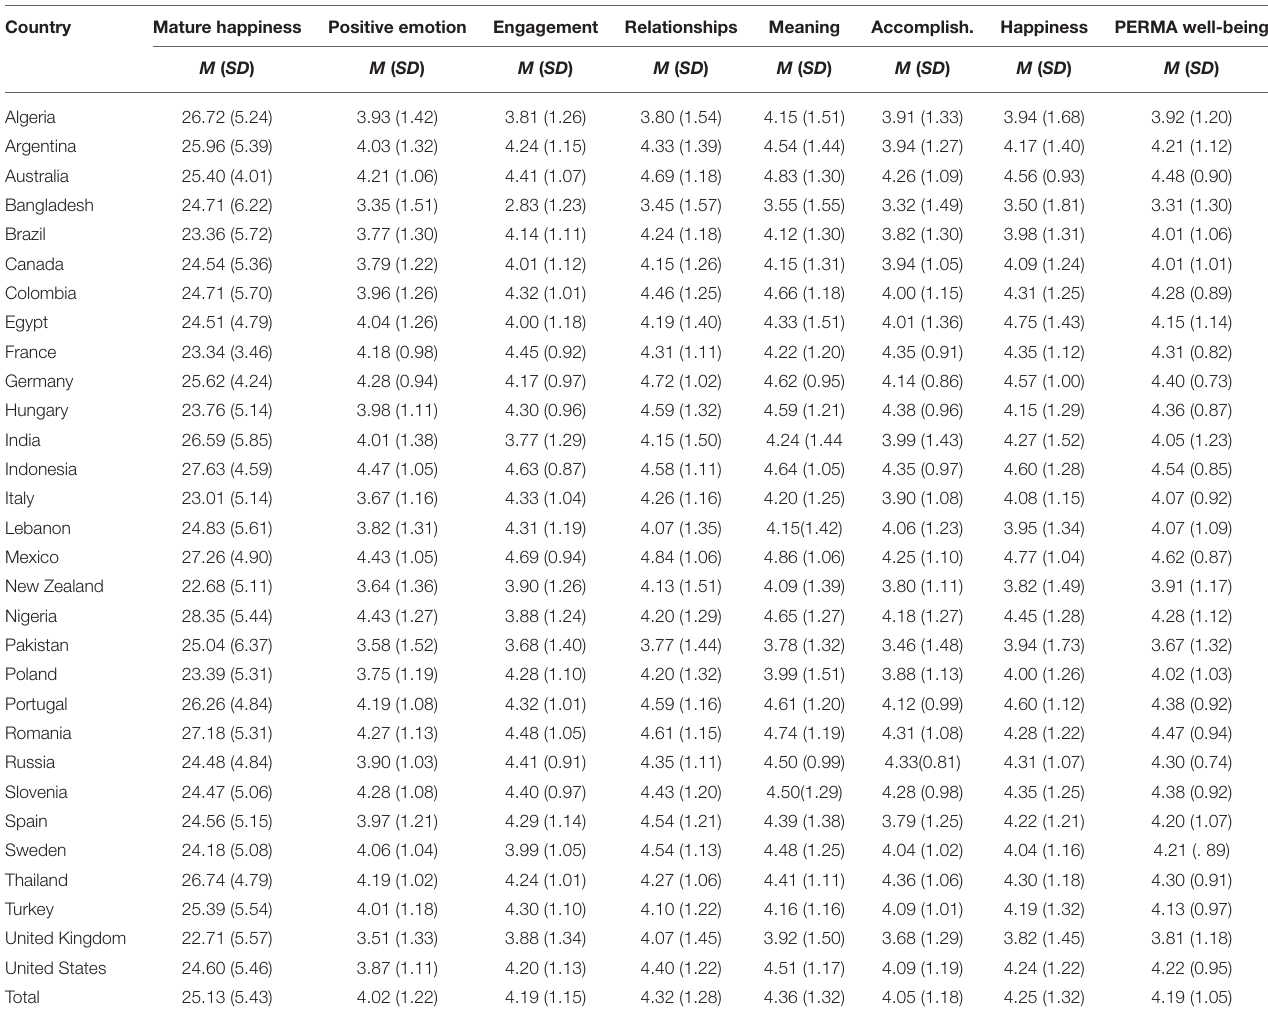
TABLE 2 | Descriptive statistics of Mature Happiness and PERMA subscales ( N = 12,203). Country Mature happiness Positive emotion Engagement Relationships Meaning Accomplish. Happiness PERMA